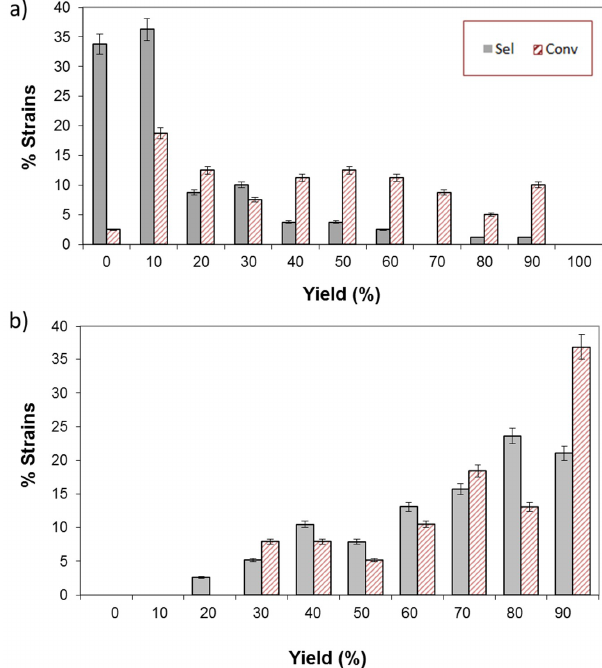
Figure 3. ( a ) Comparison of the catalytic performance of sawdust of fish (FS1) (percentage of studied strains that present a determined range of yield percentage) in the ethanolysis reaction of the totality of freeze-dried–lyophilized extracts without previous dialysis; ( b ) the same as ( a ) but after a simple previous dialysis treatment, under the same standard experimental conditions. Selectivity (Sel, %) is presented in grey, and conversion (Conv, %) in pink lines.